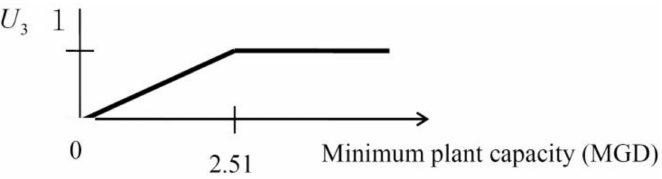
Figure 5. Membership function of the minimum plant capacity.